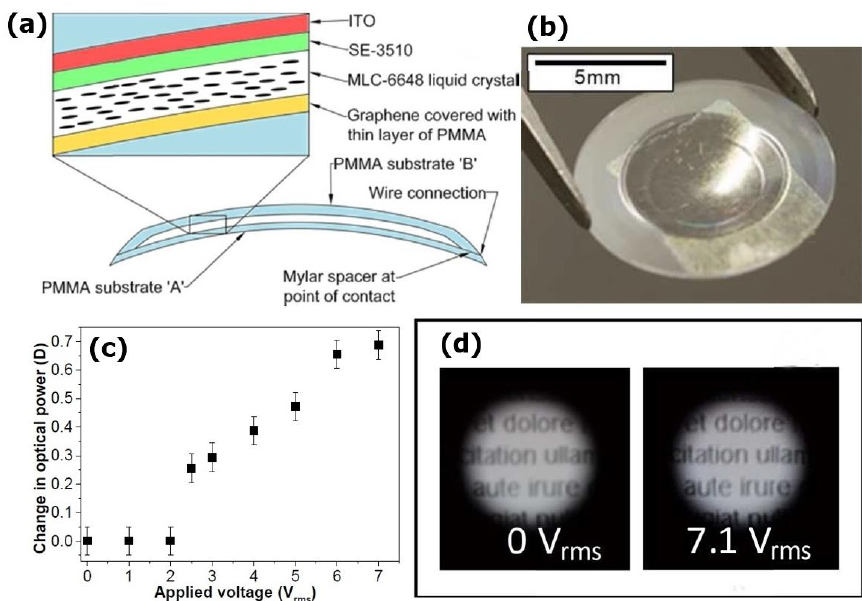
Figure 18. ( a ) Schematic of a graphene electrode flexible contact lens. ( b ) Substrate of the contact lens with deposited graphene film electrode, covering the whole curved active area. ( c ) Change of the optical power of the lens as a function of applied voltage, allowing changes from 0–0.7 D. ( d ) Focussing a text by application of a voltage. (Reproduced by permission from [172]).